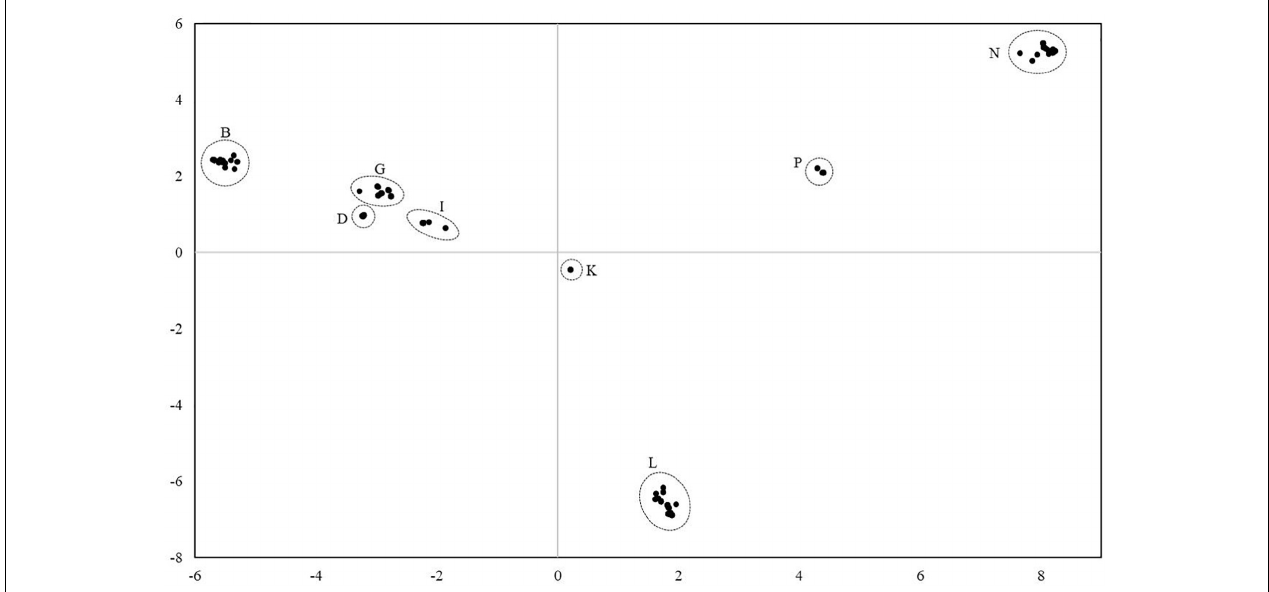
FIGURE 3 | Principal coordinate analysis plot of 271 Holstein mares from 75 lineages considering the mitochondrial genome reveals eight major haplogroups. Haplogroups were named according to Achilli et al. (2012). All mares from one lineage were assigned to the same haplogroup.